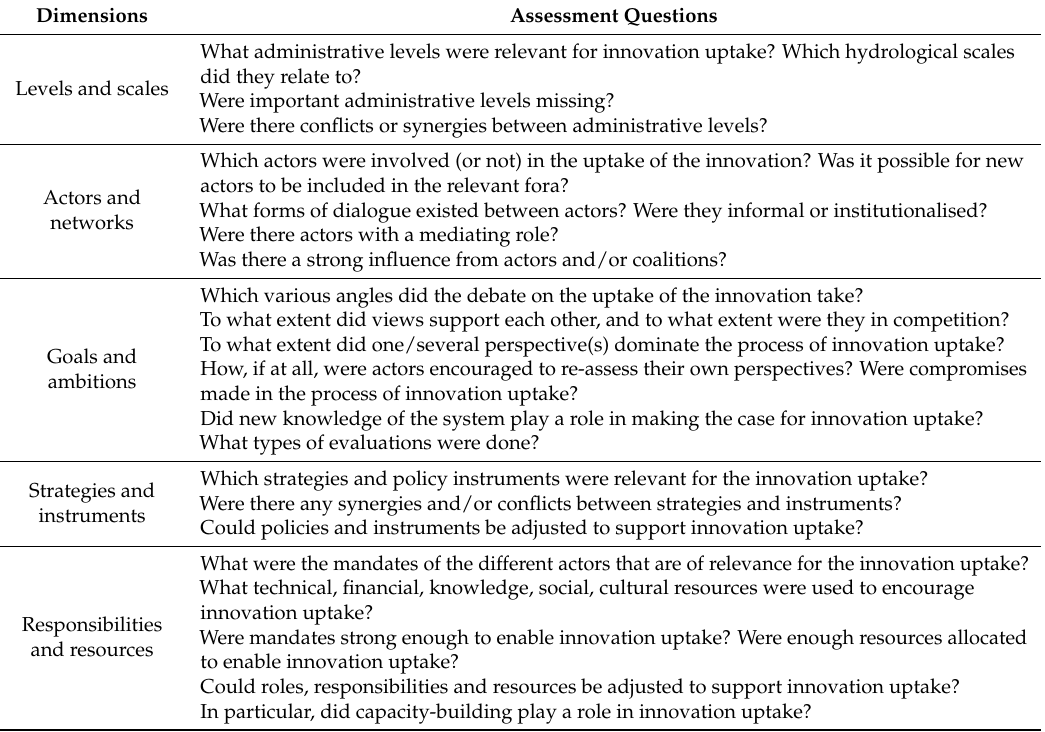
Table 1. Questions of the assessment framework for innovation uptake in urban water